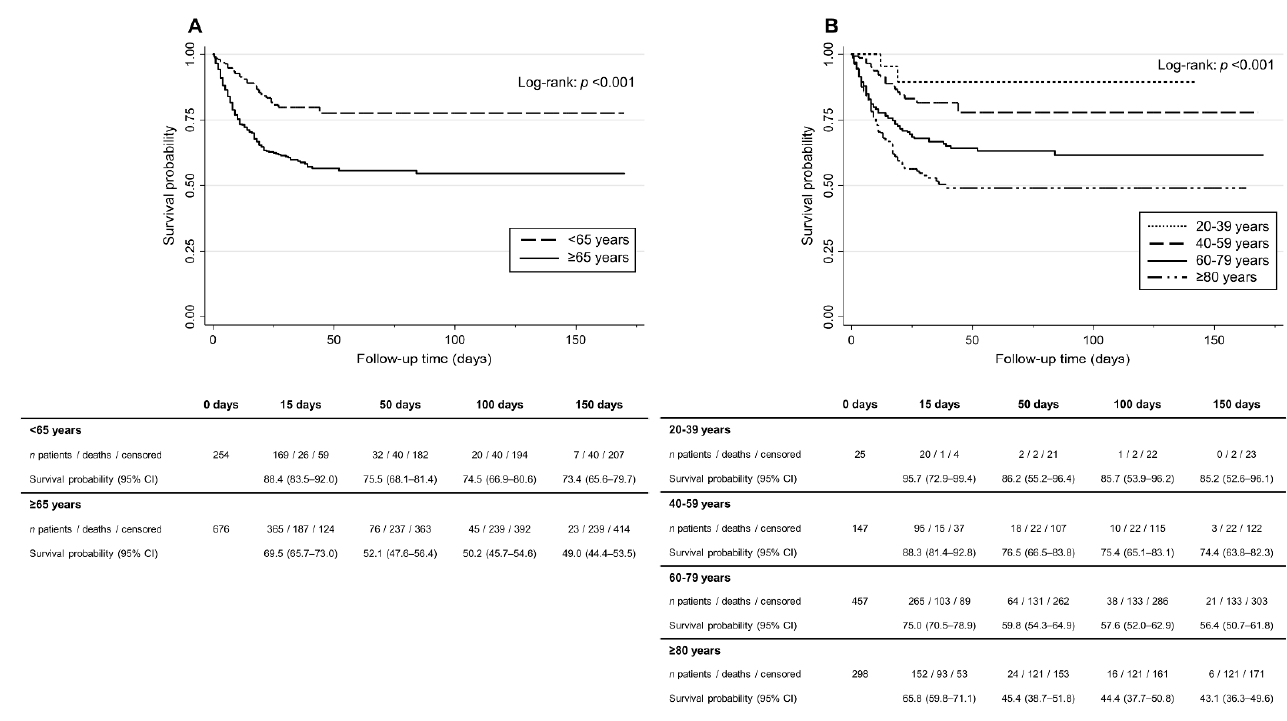
Figure 2. Kaplan–Meier survival curves for all-cause mortality in the haemodialysis population: distribution by age. ( A ) Survival differences between elderly (≥65 years-old) and non-elderly (<65 years-old) population; ( B ) Survival differences within haemodialysis population by age range. HD: Haemodialysis.